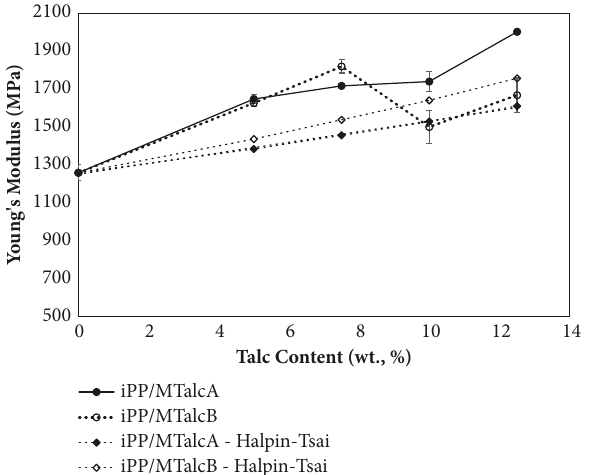
Figure 6: Young’s modulus versus filler content curves of compos- ites based on iPP/MTalc A and iPP/MTalc B, experimental data and predicted values determined by Modified Guth